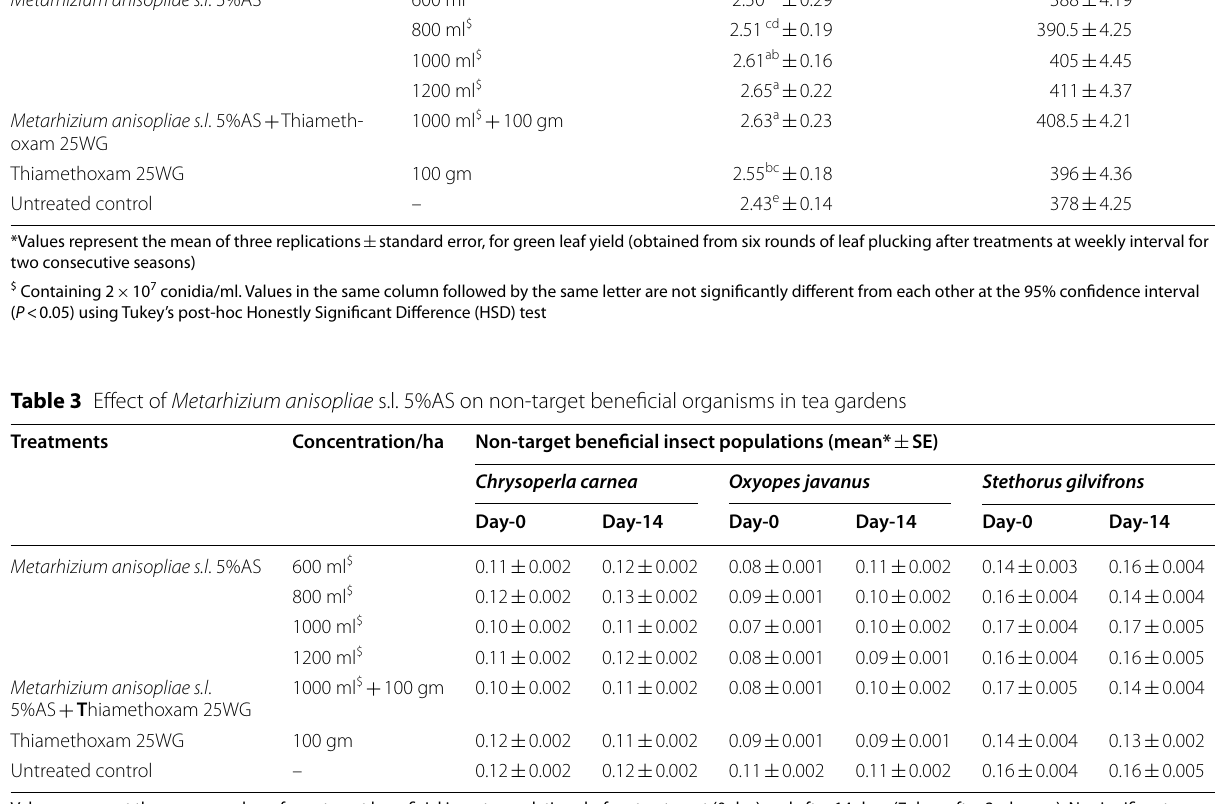
Values represent the mean number of non-target beneficial insect populations before treatment (0 day) and after 14 days (7 days after 2nd spray). No significant differences were recorded for each species of test insects population, between the 0 day and after 14 days ( P > 0.05; independent t-test) $ Containing 2 10 7 conidia/ml × *Values represent the mean of three replications Standard Error